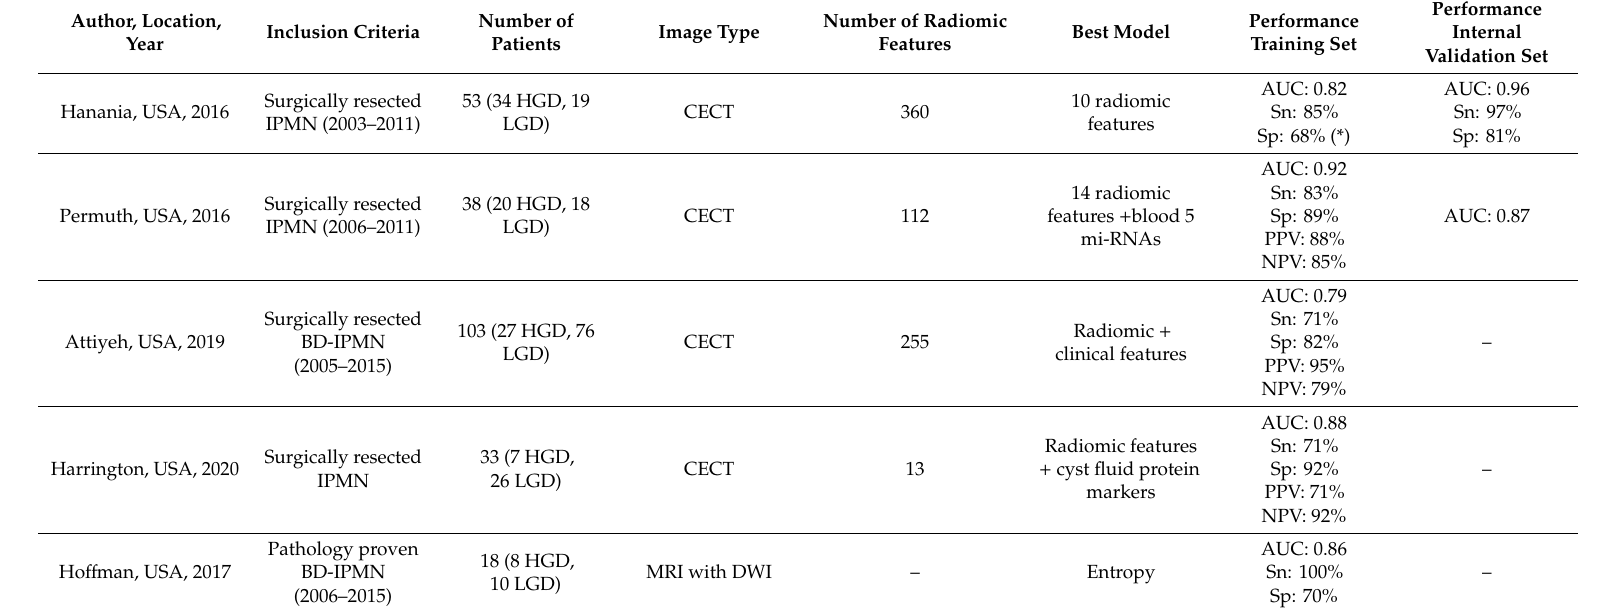
Table 3. Summary of studies evaluating the role of radiomics on di ff erentiating IPMNs with and without advanced